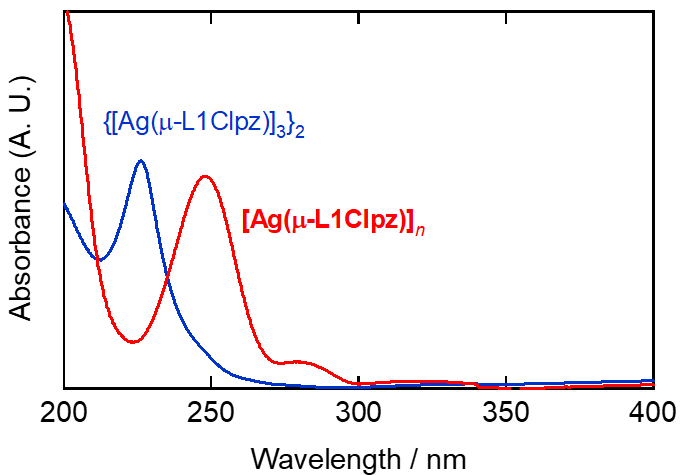
Figure 5. Solid-state UV-Vis absorption spectra of [Ag(μ -L1Clpz)] n (red line) and {[Ag(μ -L1Clpz)] 3 } 2 (blue line) [20] recorded in a Nujol mull. The emission spectrum of [Ag(μ -L1Clpz)] n in the solid-state was also somewhat different from that of the hexanuclear silver(I) analogue {[Ag(μ -L1Clpz)] 3 } 2 [20] as shown